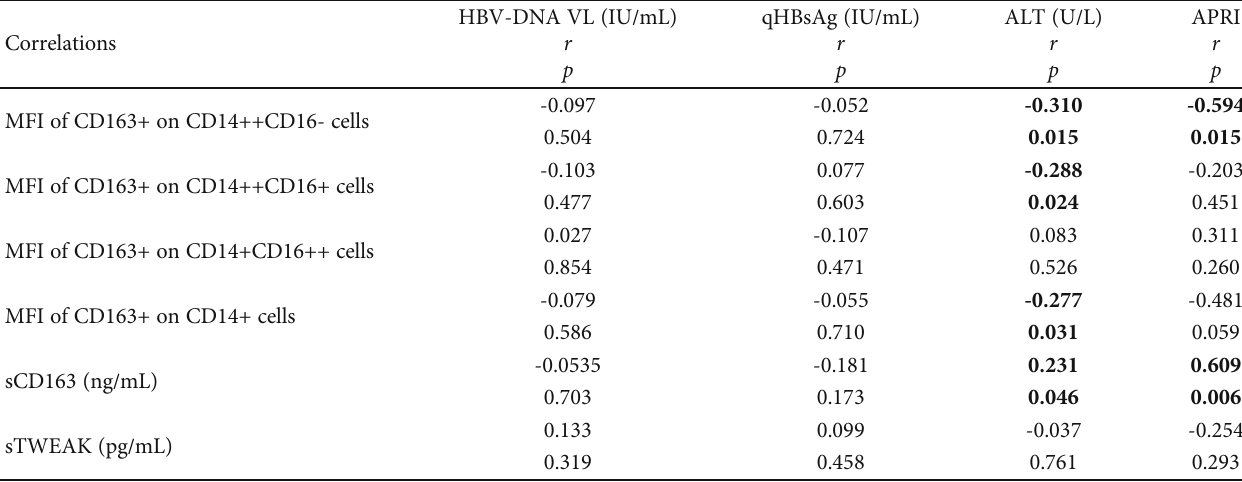
Table 4: Correlation of VL, qHBsAg, ALT, and APRI with CD163 expression on monocytes, sCD163, and sTWEAK.